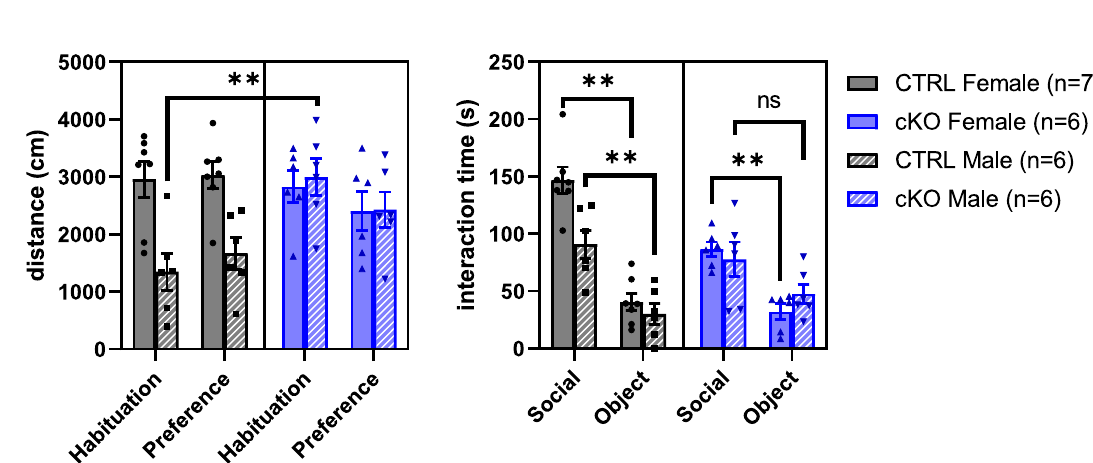
Figure 5. Male Ca V 1.2 cKO mice display impaired social preference on the three-chamber social preference task. ( a ) Male cKO mice were more active than CTRL littermates during habituation but there were no sex or genotype differences in distance traveled during the preference phase. ( b ) Male Ca V 1.2 cKO mice do not spend more time with a conspecific mouse compared to a novel object, but all other groups display preference for spending time with a conspecific mouse over a novel object. Female cKO mice also spend less time in social interaction than CTRL female mice. Data are expressed as mean ± s.e.m, using EthoVision 14, www. noldus. com/ ethov ision- xt.